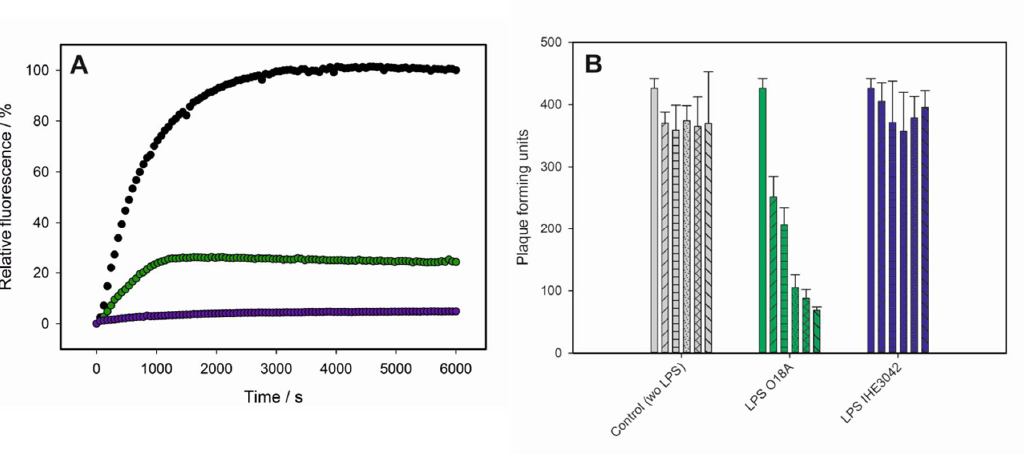
Figure 5. Interaction of phage HK620 with non-host E. coli strains. ( A ) DNA ejection from phage HK620 (6.7 × 10 9 pfu) in the presence of the fluorescent DNA-binding dye Yo-Pro at 45 °C triggered by LPS (16.7 µg/mL) with O-antigen serotype O18A1 from E. coli H TD2158 (O18A1) (black) or E. coli IHE3042 (O18A1) (green) or serotype O18A from E. coli DSM10809 (O18A) (purple). ( B ) In vivo plaque forming assay after incubation of 4.5 × 10 3 pfu mL −1 HK620 particles with 25 µg mL −1 LPS from E. coli DSM10809 (O18A) (green) or E. coli IHE3042 (O18A1) (blue). After 0, 10, 30, 120, 240, 300 min (individual bars in each experiment) the reaction mix (450 pfu) was plated on E. coli H TD2158 (O18A1) and plaques were determined after overnight incubation at 37 °C. Standard deviations are from three independent experiments.